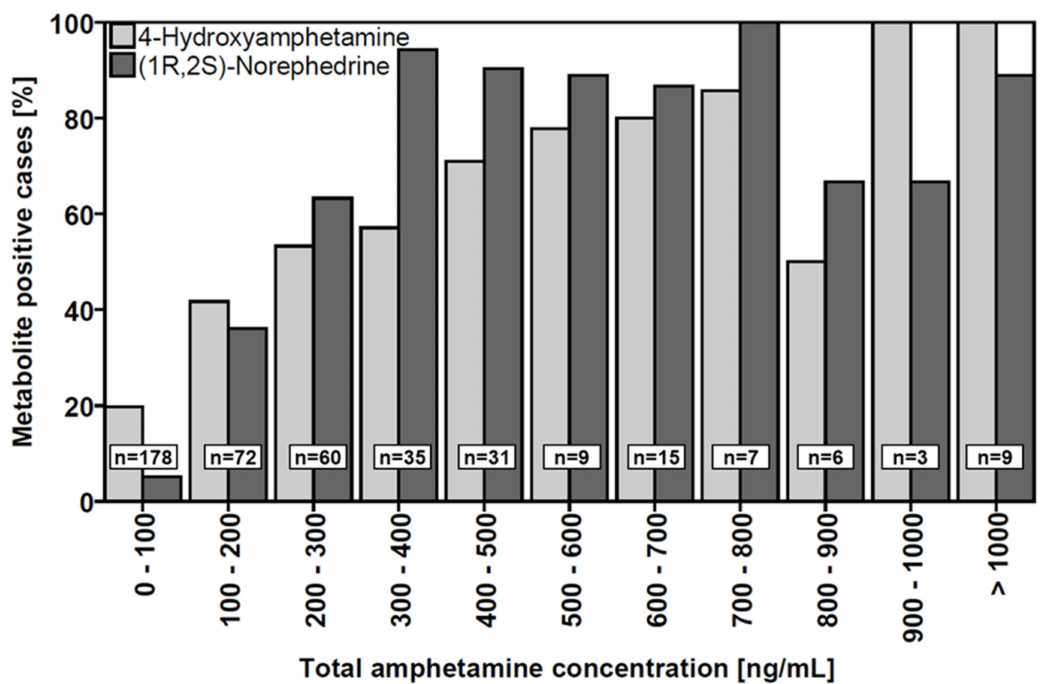
Figure 4. Histograms for relative frequency of 4-hydroxyamphetamine and (1R,2S)-norephedrine positive cases (at least 0.5 ng/mL of any enantiomer) within different total amphetamine concentration ranges. For both 4-hydroxyamphetamine and (1R,2S)-norephedrine, there was a positive correlation between positive cases and the total amphetamine concentration (one-tailed Spearman’s Rho and Kendall’s Tau each p = 0.000).